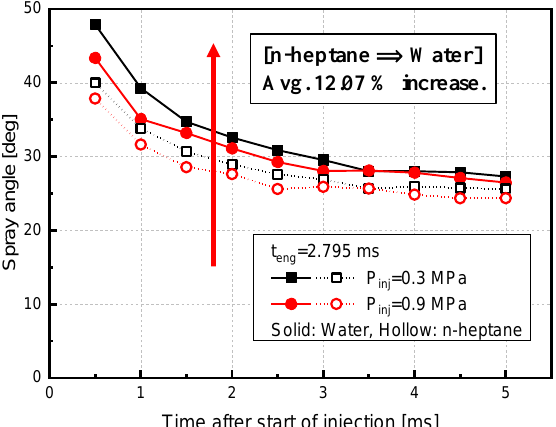
Figure 7. Spray angle characteristics of water and n-heptane according to time after start of injection (t eng = 2.795 ms).